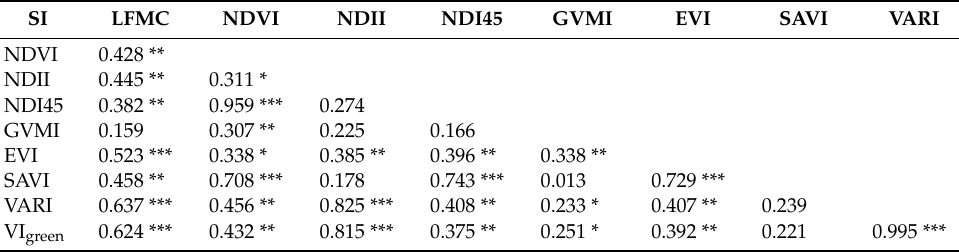
Table 4. Pearson correlation matrix for Sentinel-2 calibration dataset. Significance level: * p -value < 0.05, ** p -value < 0.01, *** p -value <